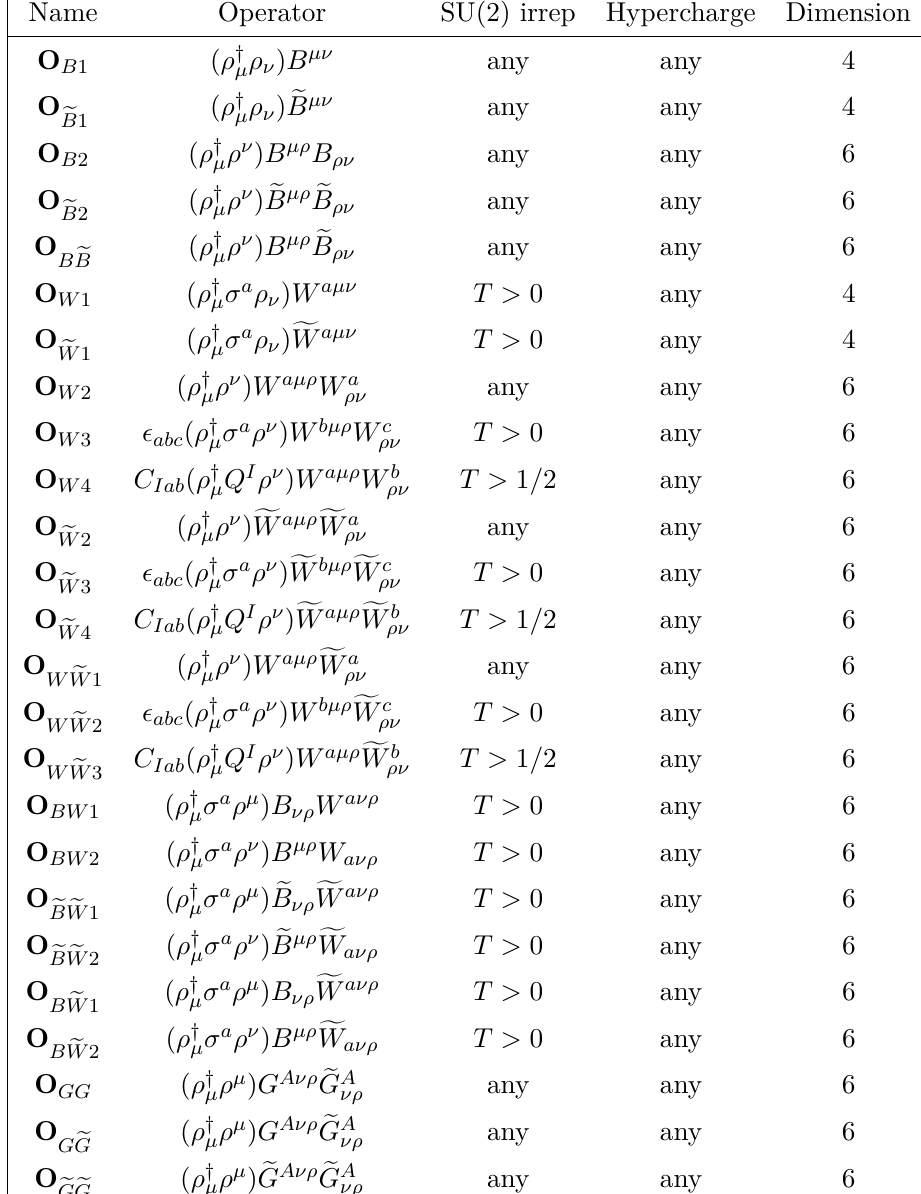
Table 7 . Basis of operators of dimension ≤ 6 with two vector DM multiplets and SM field- strength tensors only. Q I is the unique set of square matrices acting on the SU(2) part of ρ which transform covariantly as a quadruplet. C represents the quadruplet-triplet-triplet Clebsh-Gordan Iab